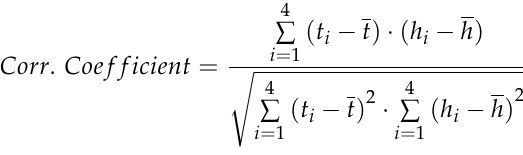
Figure 45. Correctional power analysis flow on the KATAN cipher.